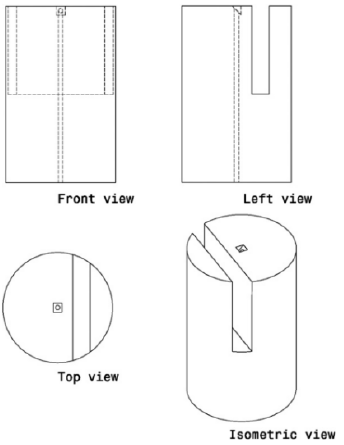
Figure 11. Three ‐ view drawings of the fiber ‐ side interferometer sensor [91]. Figure 11. Three-view drawings of the fiber-side interferometer sensor